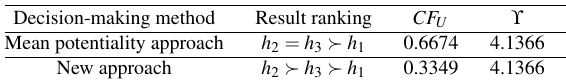
Table 14: The comparison results of the substantial uncertainty factors of overall uncertainty Decision-making method Result